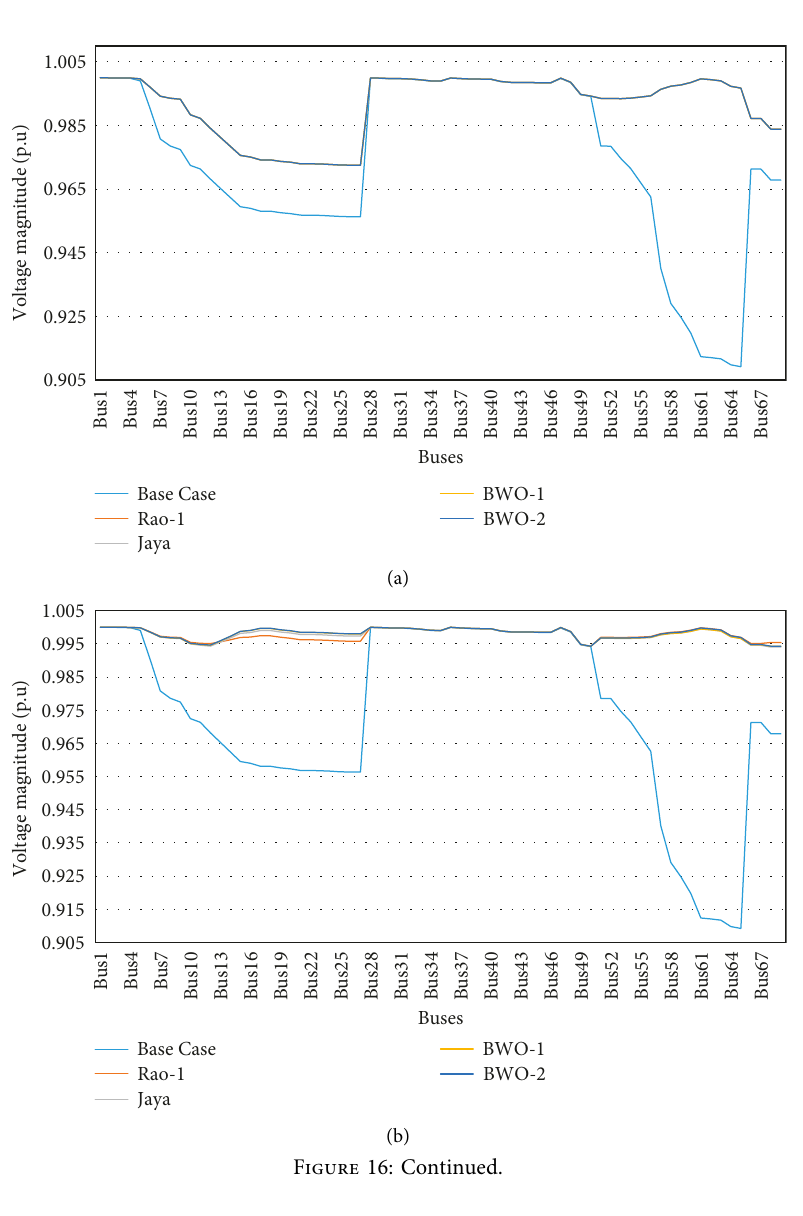
Figure 15: The power loss reductions obtained in the 69-bus distribution network for the studied three cases (a) in kW and (b) in percentage.